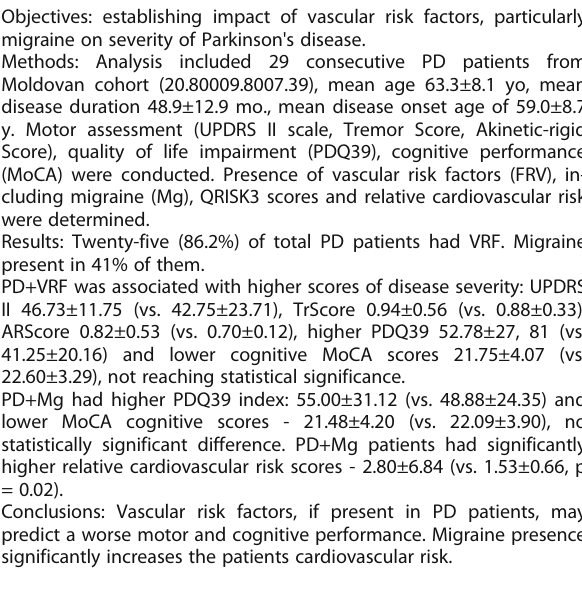
Fig. 2 (abstract P0403). See text for